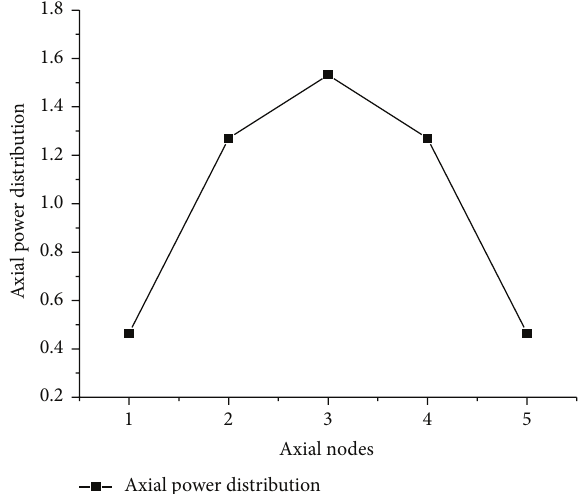
Figure 5: Axial power distribution of the reactor